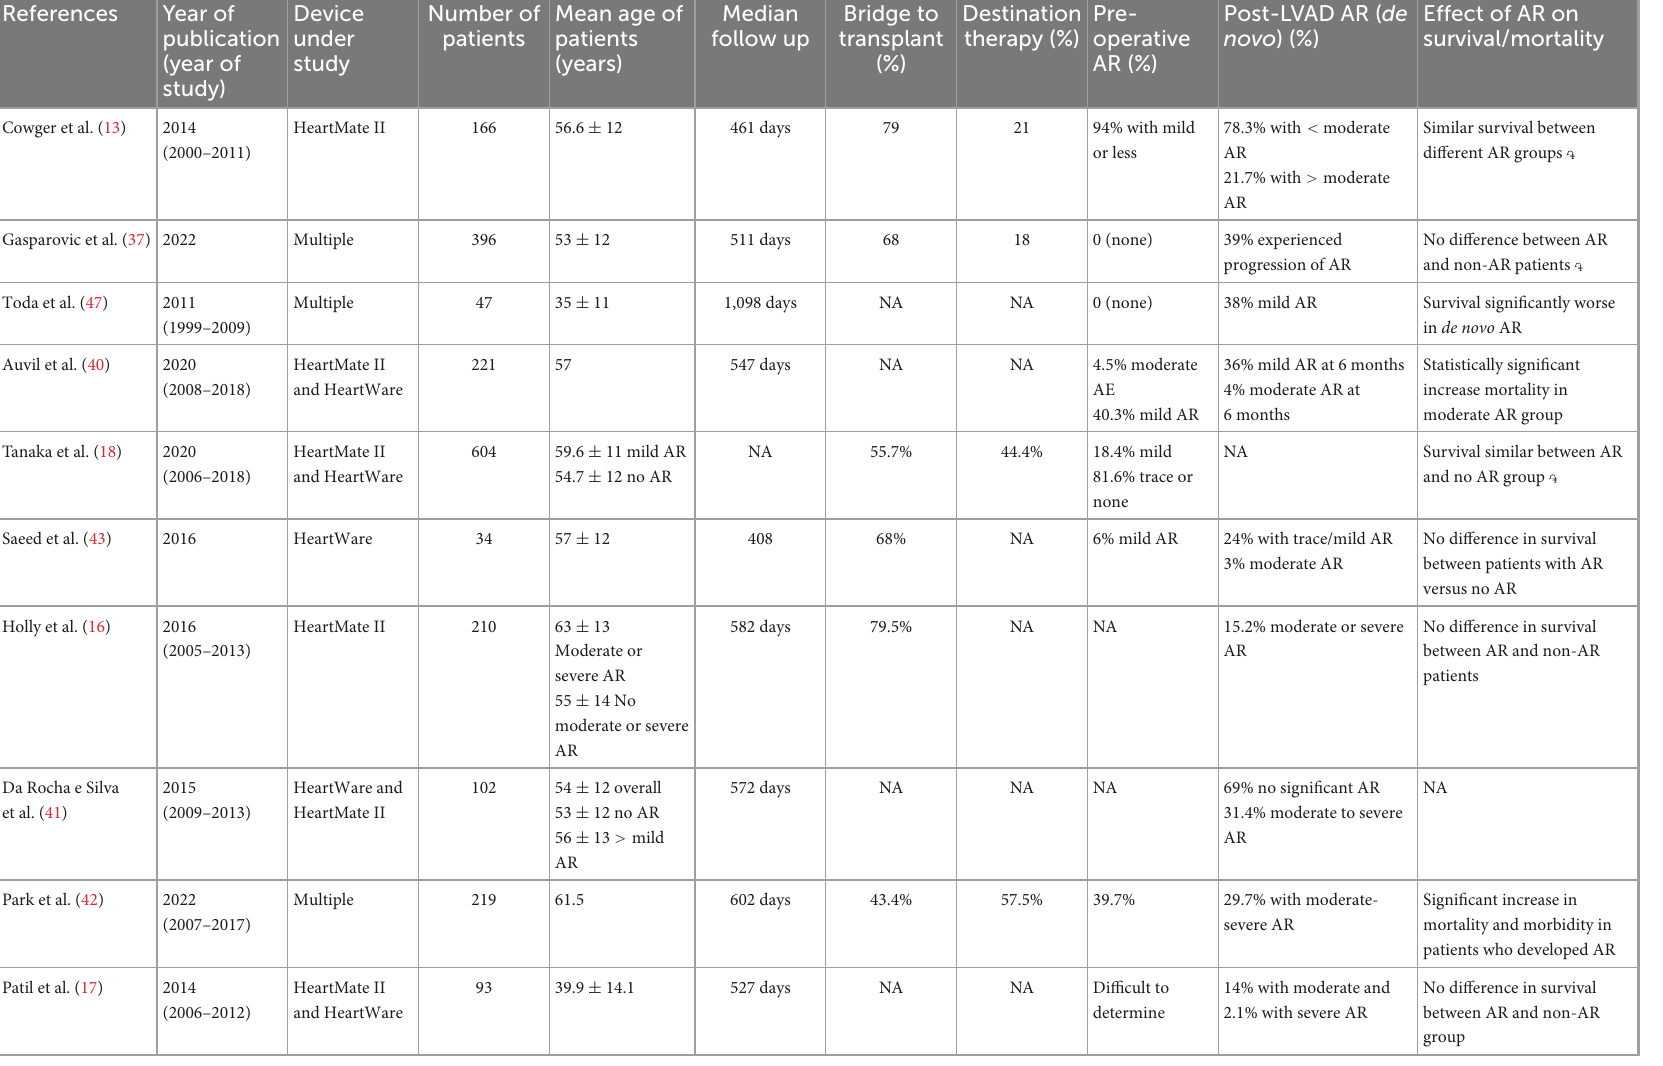
TABLE 2 Literature review of multiple studies studying the association between left ventricular assist device (LVAD) and